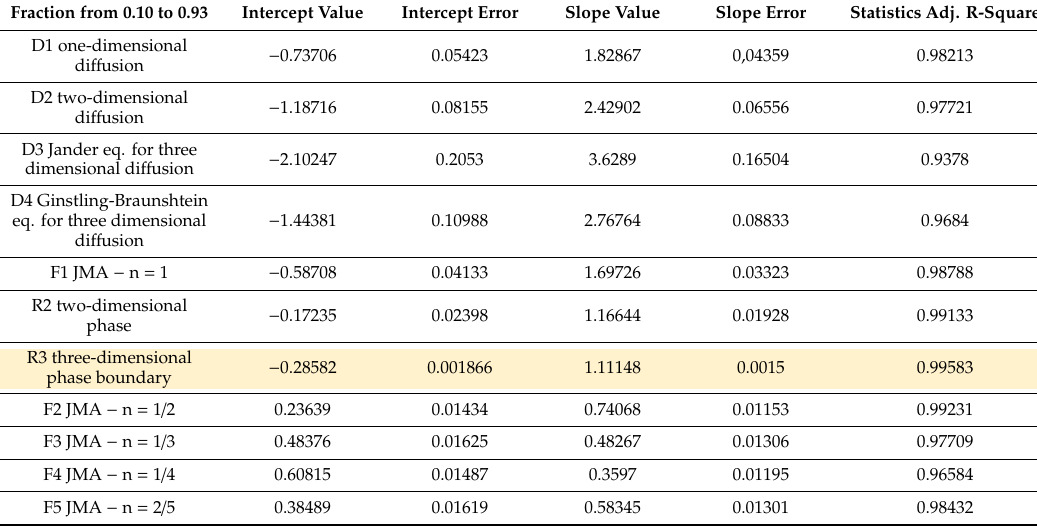
Fraction from 0.10 to 0.93